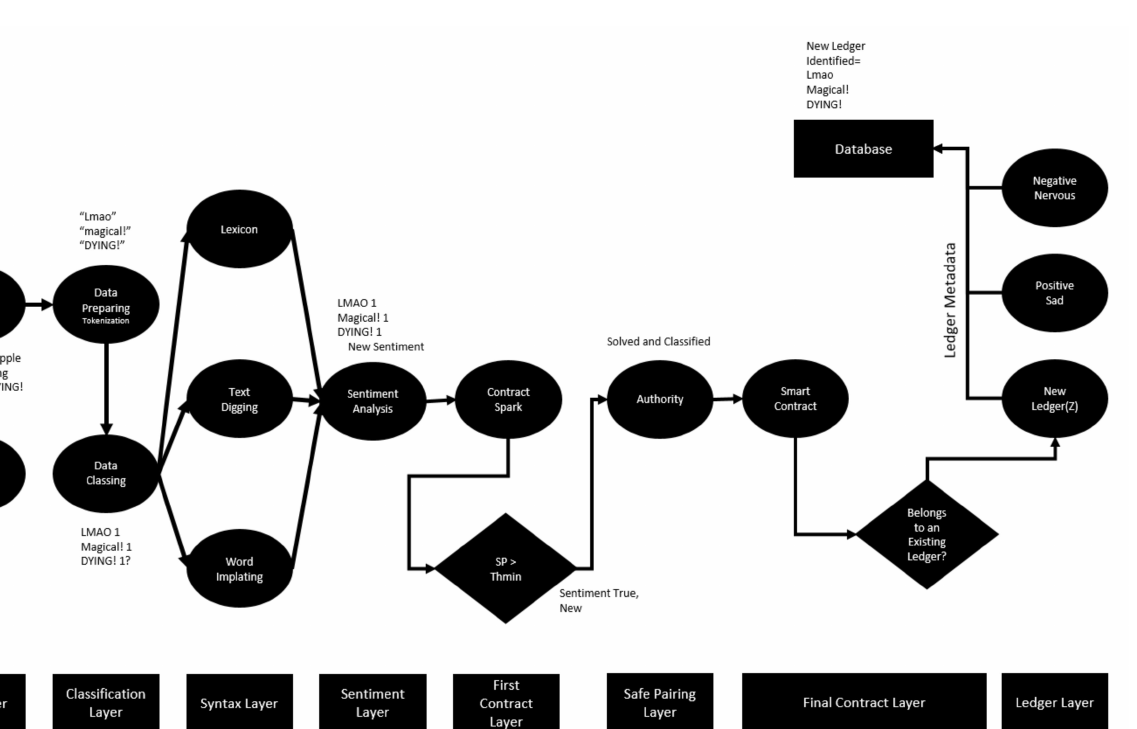
Figure 9. Newly defined sentiment entry and notebook formation data flow